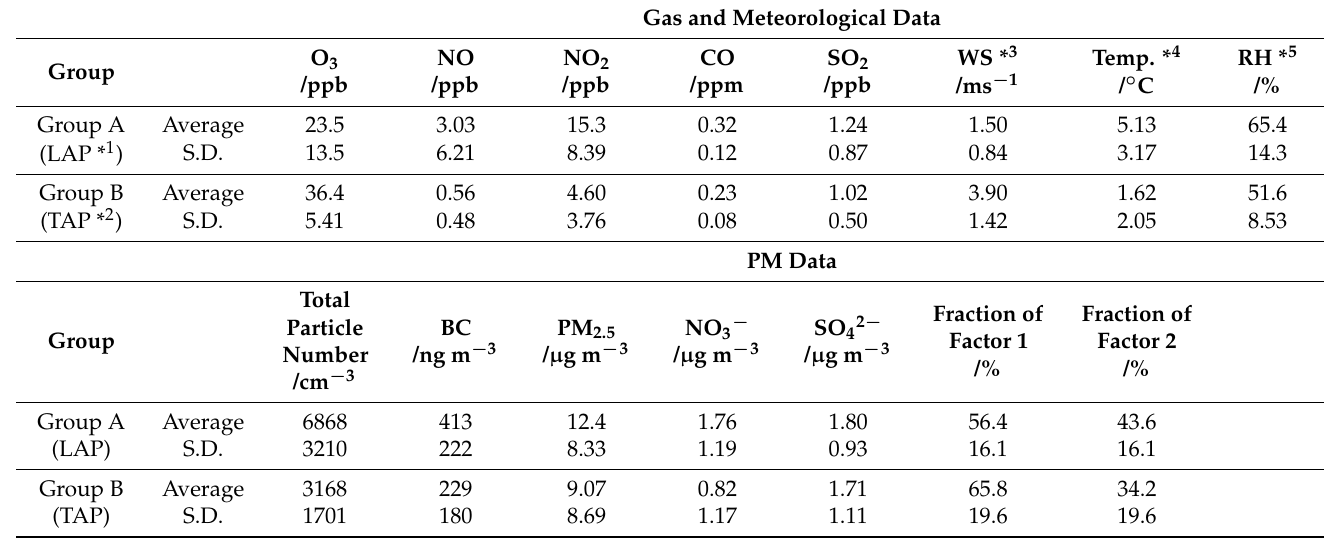
Table 1. Average values of gas, meteorological, and PM data for Groups A and